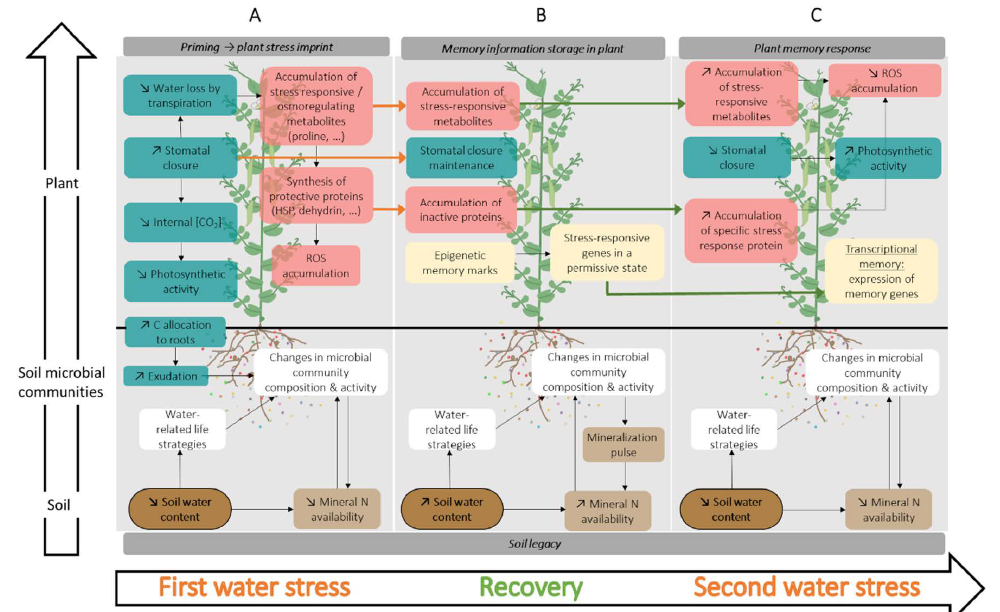
Figure 2. Water stress memory in the soil-plant system. ( A ) Effects of a first water stress on plant physiological (green boxes), biochemical (red boxes) and molecular (yellow boxes) plant responses, as well as on the soil microbial community (white and brown boxes). ( B ) Information storage by the plant and effects of rewatering on the soil. ( C ) Priming ‐ enhanced plant response to a second water stress.